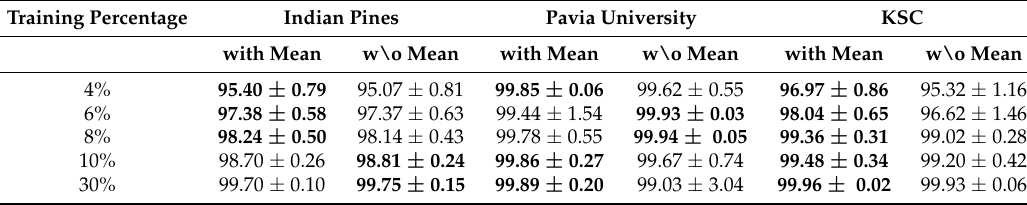
Table 4. Comparison between with mean and without mean in our proposed network (Bold represents the best results in the experiment setup). Training Percentage